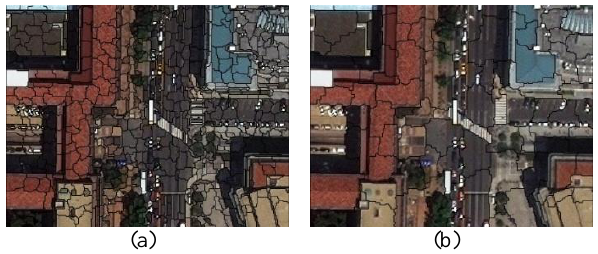
Figure 12. Segmentation Result at (a) scale=10, shape=0.7 compactness=0.7, and (b) scale=25,